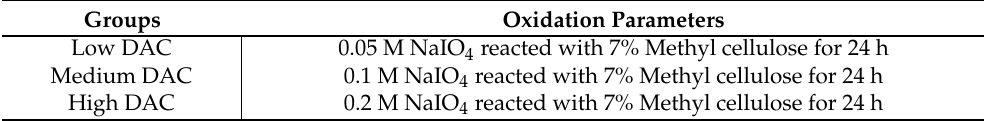
Table 1. DAC preparation